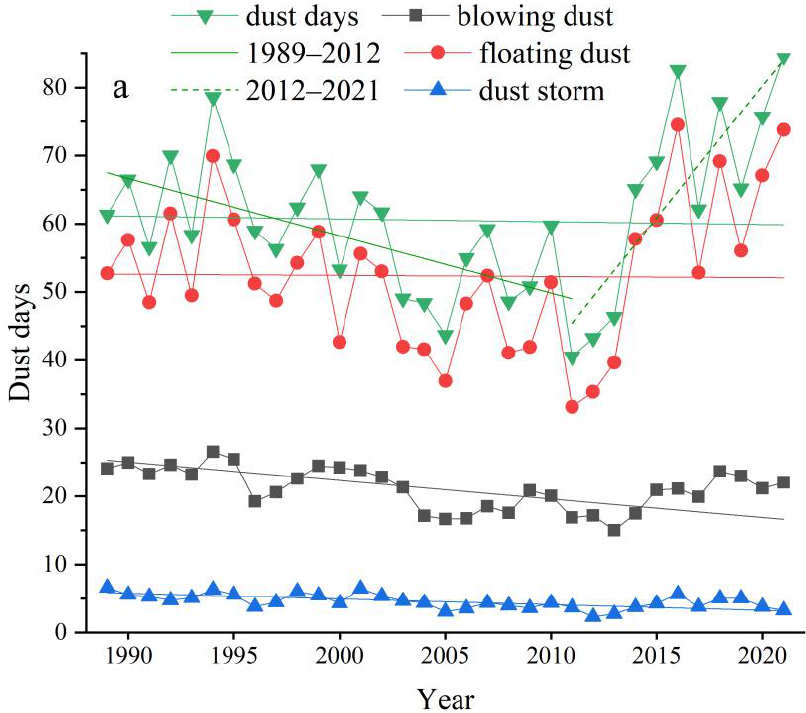
Figure 2. Frequency change of dust weather from 1989 to 2021.